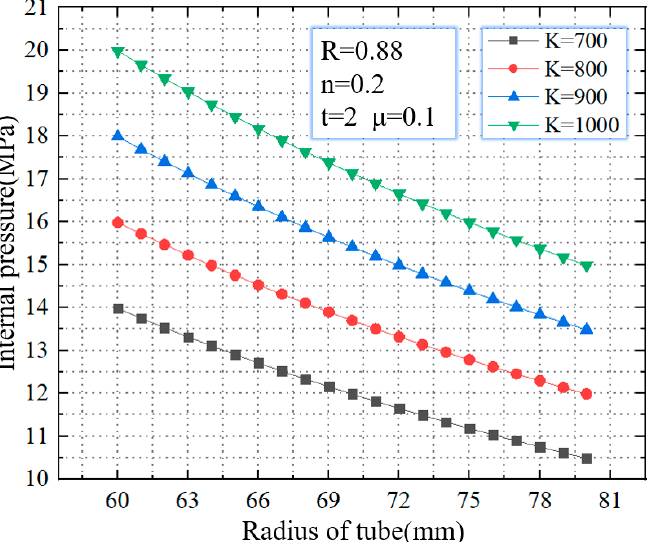
Figure 11. Critical internal pressure for rupture with different strength coefficients.